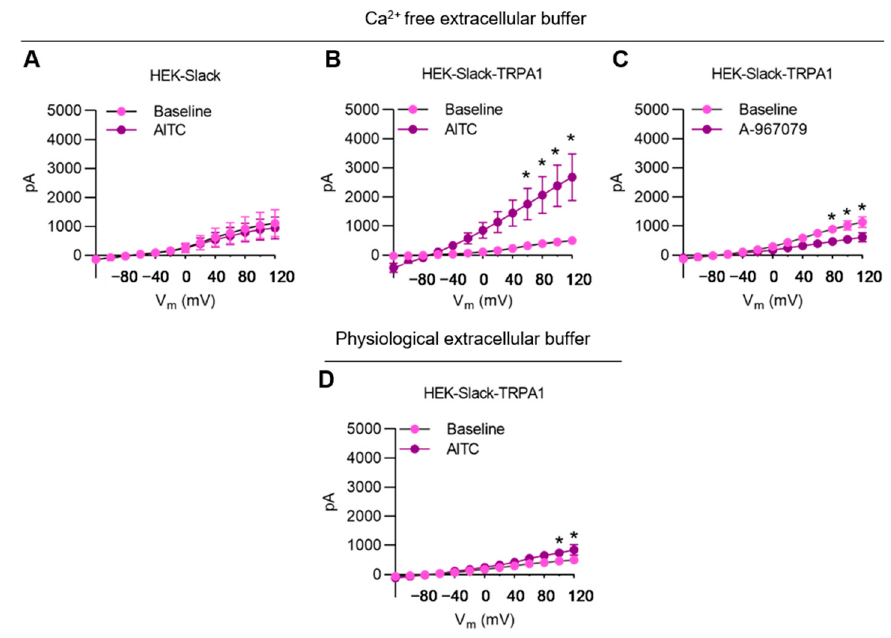
Figure 6. AITC-mediated modulation of potassium currents in transfected HEK293 cells. ( A , B ) IV relations of I K in HEK-Slack cells (( A ); n = 5 cells) and HEK-Slack-TRPA1 cells (( B ); n = 14 cells) obtained in whole-cell patch-clamp recordings using a Ca 2+ -free external solution before and after TRPA1 activation by 200 µM AITC. ( C ) IV relations of I K in HEK-Slack-TRPA1 cells before and after TRPA1 inhibition by 10 µM A-967079 ( n = 9 cells) in whole-cell patch-clamp recordings using a Ca 2+ - free external solution. ( D ) IV relations of I K in HEK-Slack-TRPA1 cells before and after 200 µM AITC application ( n = 9 cells) in whole-cell patch-clamp recordings in physiological extracellular buffer Note that in a Ca 2+ -free external solution, Slack-mediated I K is increased after TRPA1 activation. Data are presented as mean ± SEM. Paired t test, * p < 0.05.